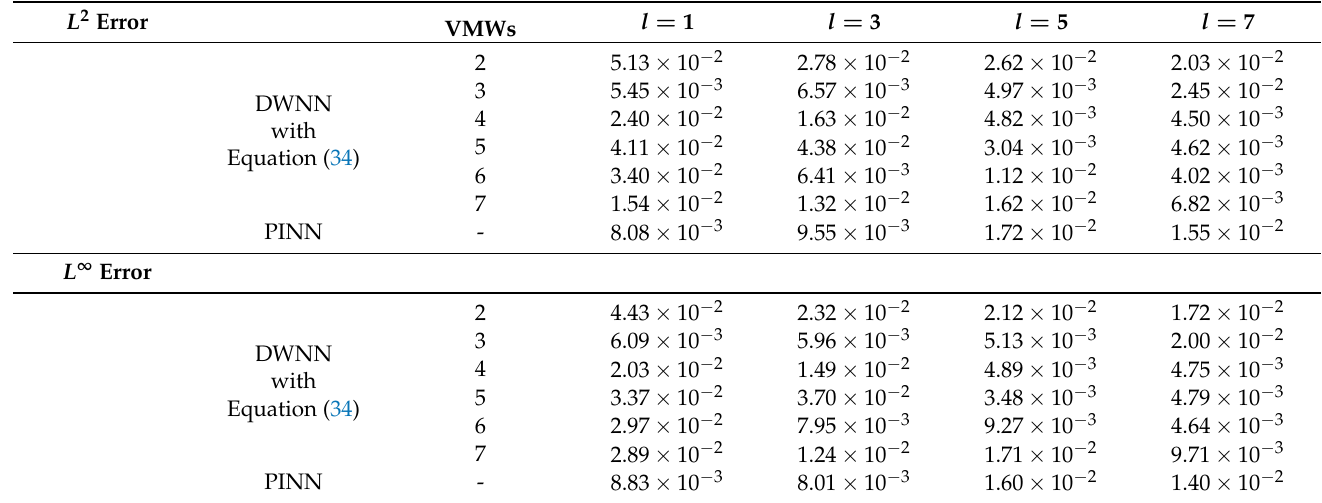
Table 4. The L 2 errors and L ∞ errors for 1D